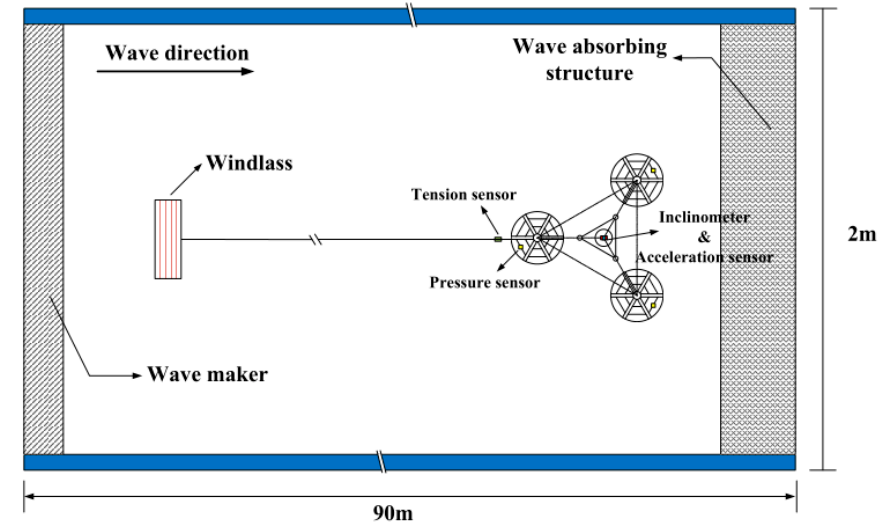
Figure 8. Schematic illustrating the wet ‐ towing stability test.